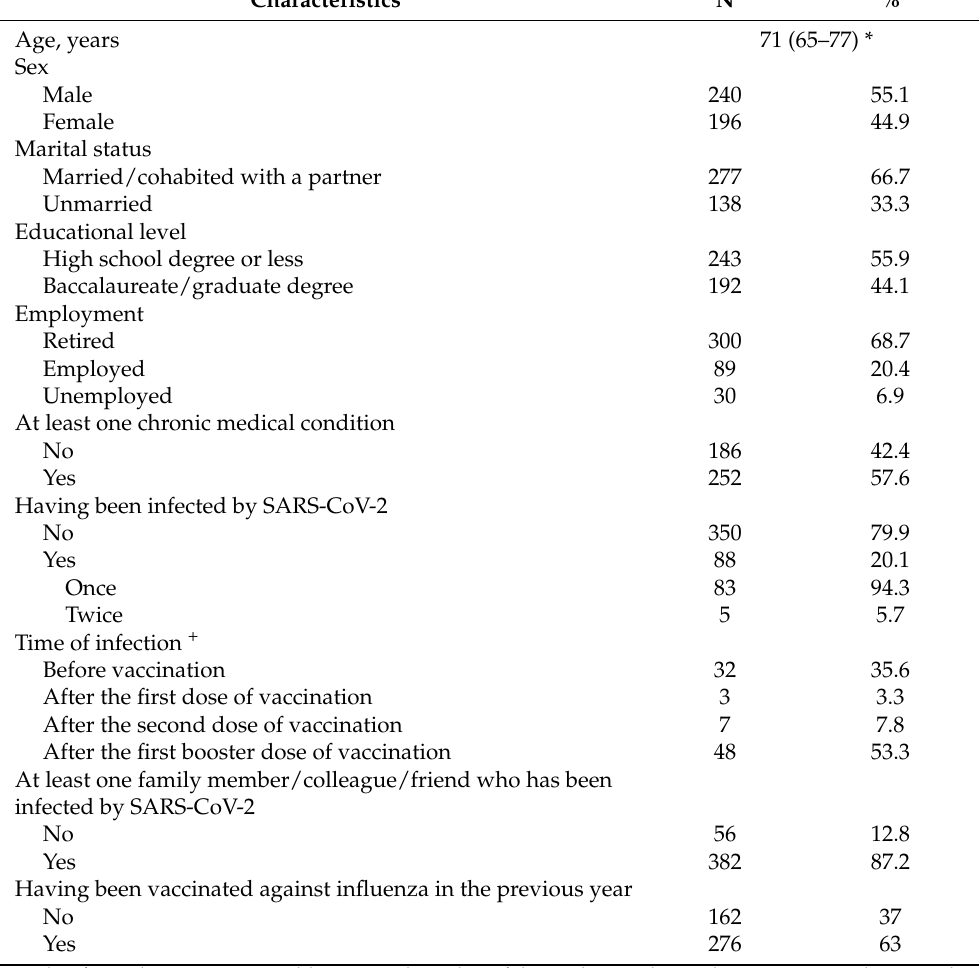
Table 1. Main socio-demographic and general characteristics of the